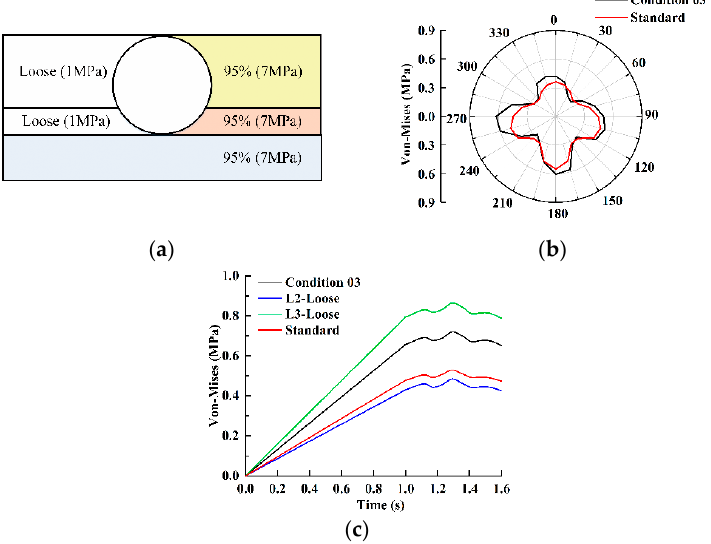
Figure 22. ( a ) The backfilling schematic of Condition 03; ( b ) the stress distribution of the pipe; ( c ) the time history curve of the left springline under Condition